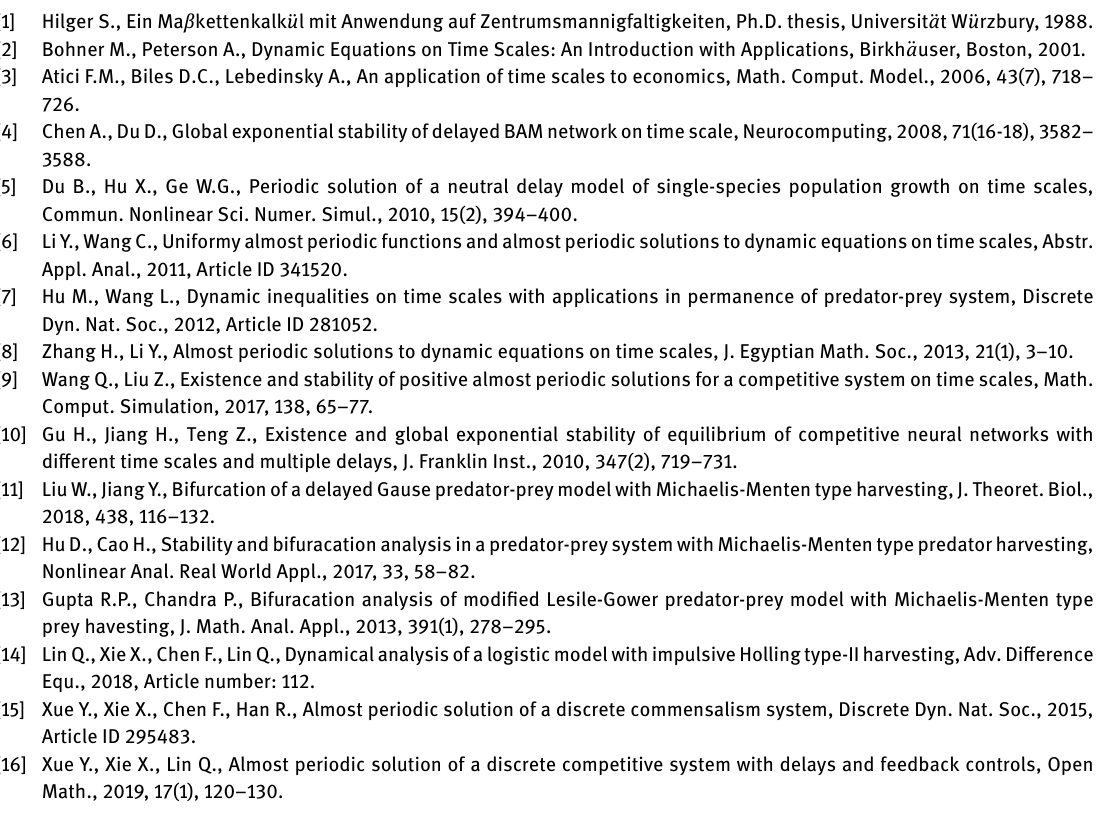
(0) = 1.8, 1.5 and 1 , respec- 1